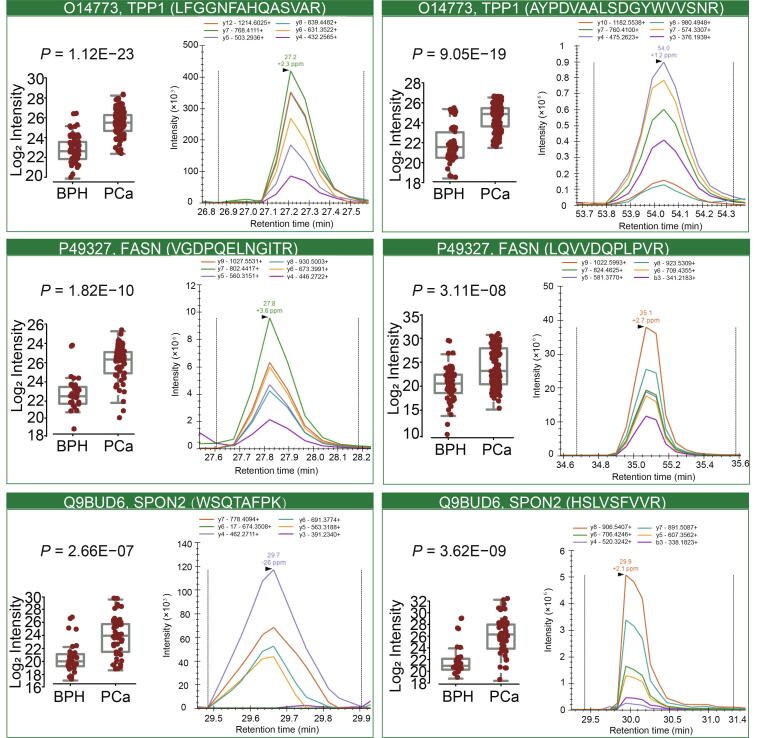
PRM validation of TPP1, FASN, and SPON2 across 73 peptide samples from 53 PCa patientsTwo best flying peptides were selected for each protein. For each peptide, boxplot shows the relative abundance of the peptide across 73 PRM runs as calculated from MS intensity (on the left), and XIC demonstrates a representative peak group of the peptide (on the right). P values are computed using Student’s t test. PRM, parallel reaction monitoring; XIC, extracted ion chromatogram.